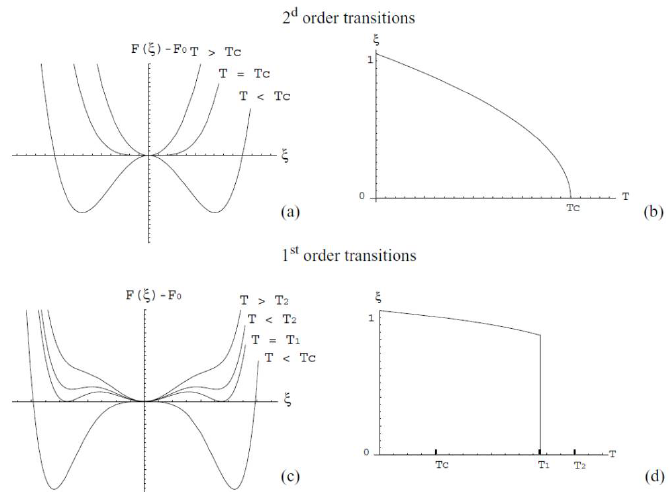
Figure 34. The free energy F function of the order parameter ξ and temperature T , and the order parameter function of the temperature T , in the case of ( a , b ) second order transitions, or of ( c , d ) first order transitions.